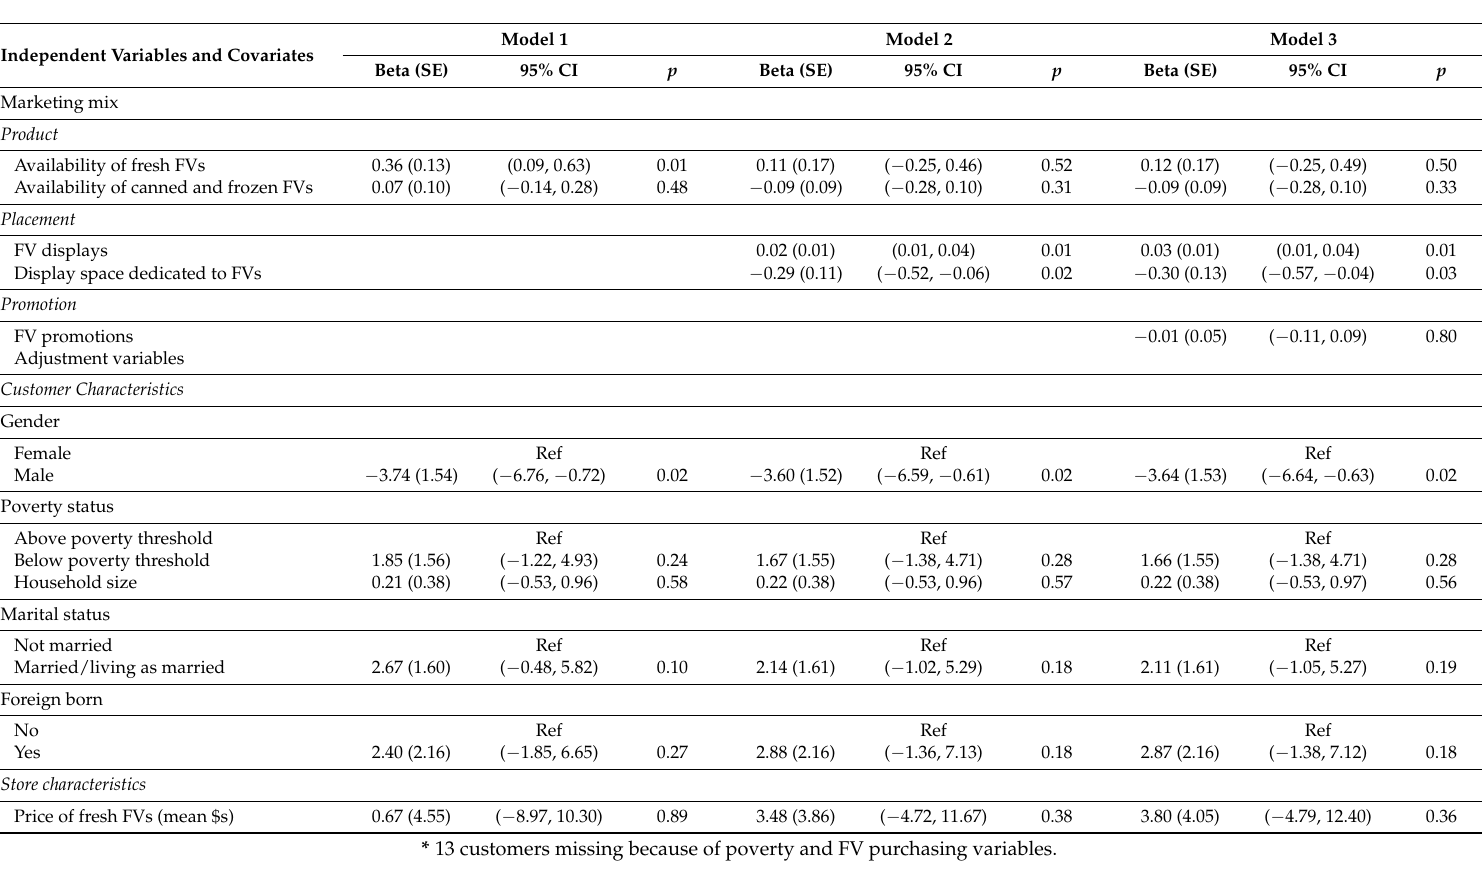
Table 3. Linear regression mixed models examining differences in the adjusted relationship between customer-reported FV purchasing and the introduction of each in-store environmental characteristics—product, placement, and promotion, n = 356